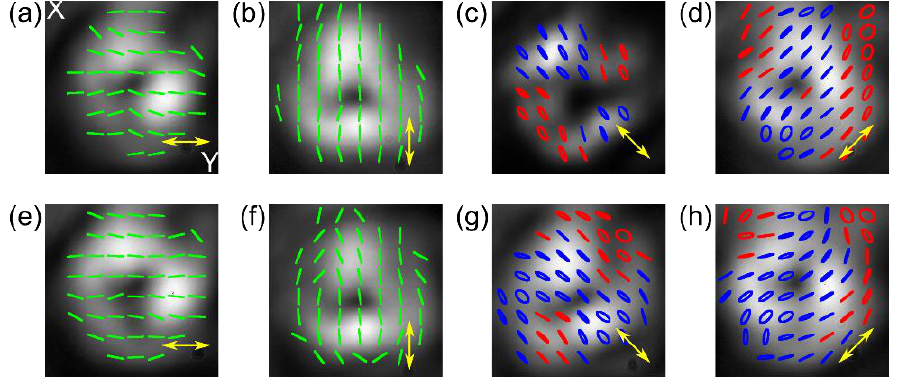
Figure 5. The intensity and polarization distribution of generated vector vortex beams that result from the conversion of ( a – d ) linear (vertical) polarized Gaussian input beam; ( e – h ) left-handed circular polarized input Gaussian beam for U 1 = 0 V, U 3 = 5 V driving voltages, and for the following U 2 voltages: ( a ) U 2 = 2.2 V; ( b ) U 2 = 1.3 V; ( c ) U 2 = 1.6 V; ( d ) U 2 = 3.3 V; ( e ) U 2 = 3.3 V; ( f ) U 2 = 1.6 V; ( g ) U 2 = 2.2 V; ( h ) U 2 = 1.3 V.